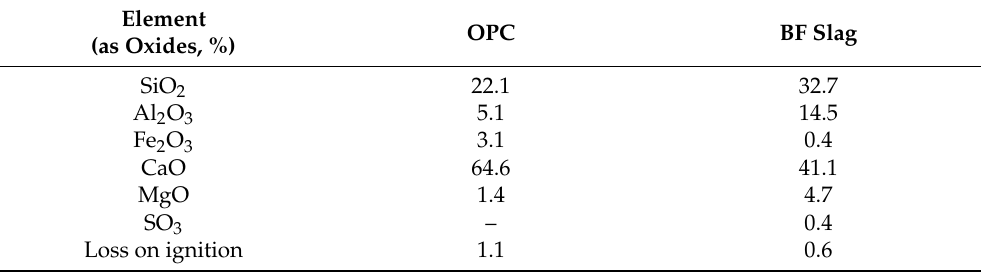
Table 2. Chemical compositions of cement and blast furnace